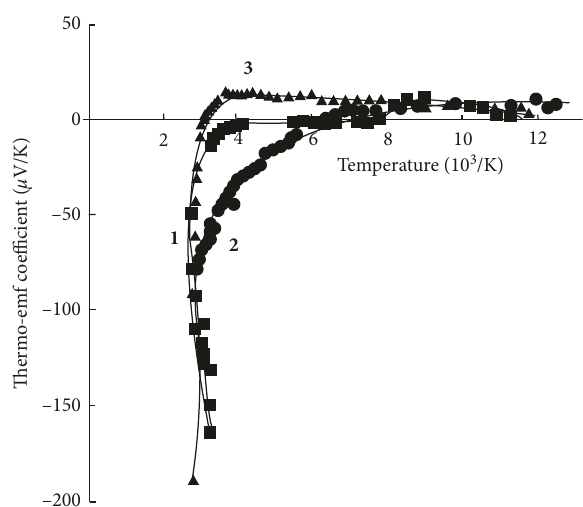
Figure 3: Temperature dependences of thermo-emf coefficient in